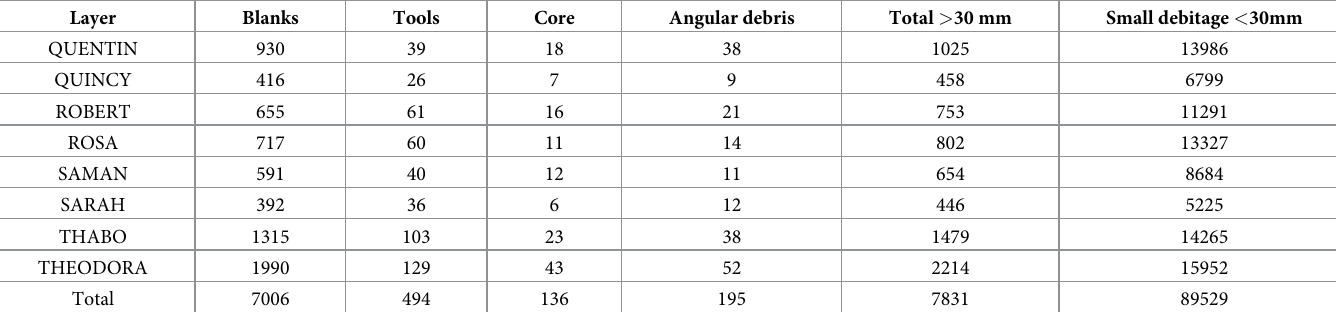
Table 2. Distribution of debitage categories ( � 30 mm) and small debitage ( < 30 cm) in each layer of the Sibudu